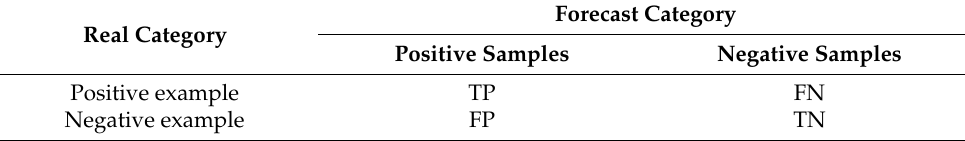
Table 8. Confusion